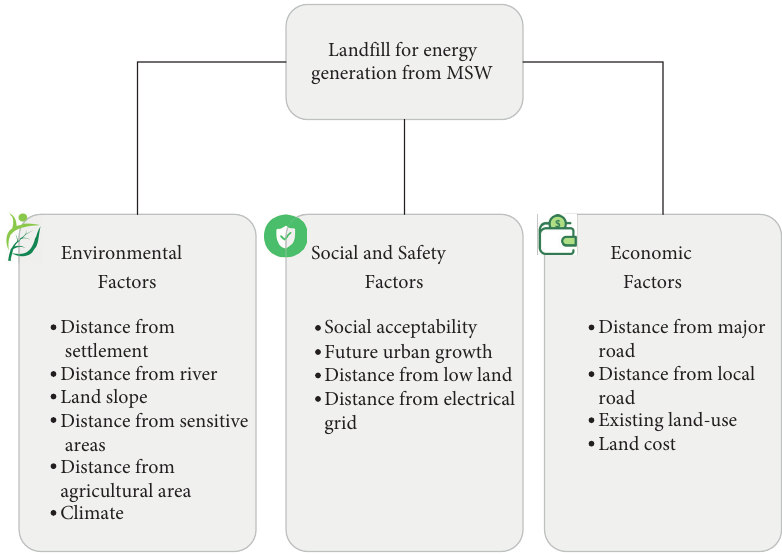
Figure 5: The factor hierarchy of site suitability for energy